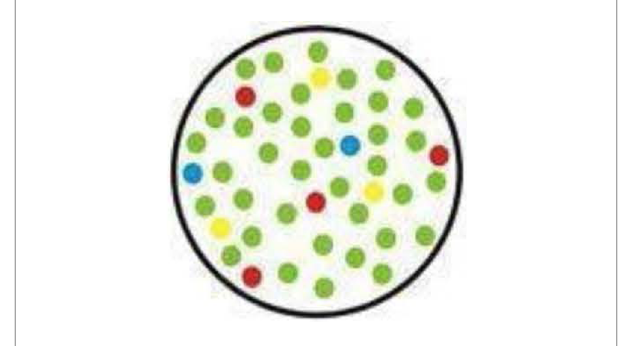
FIGURE 1 Integration in sport. Figure 1 was produced by think inclusive by MCIE as part of a schematic that re fl ects possible outcomes of integrative and inclusive practices in